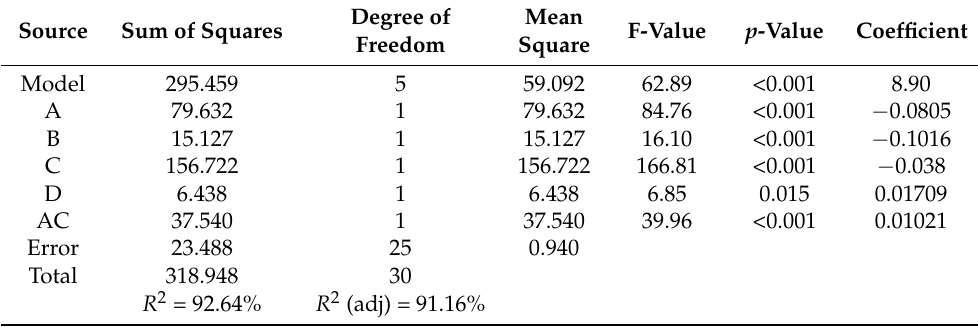
Table 4. The ANOVA of the reduced regression model for the material removal rate (MRR) of EDM with multi-aperture flushing .